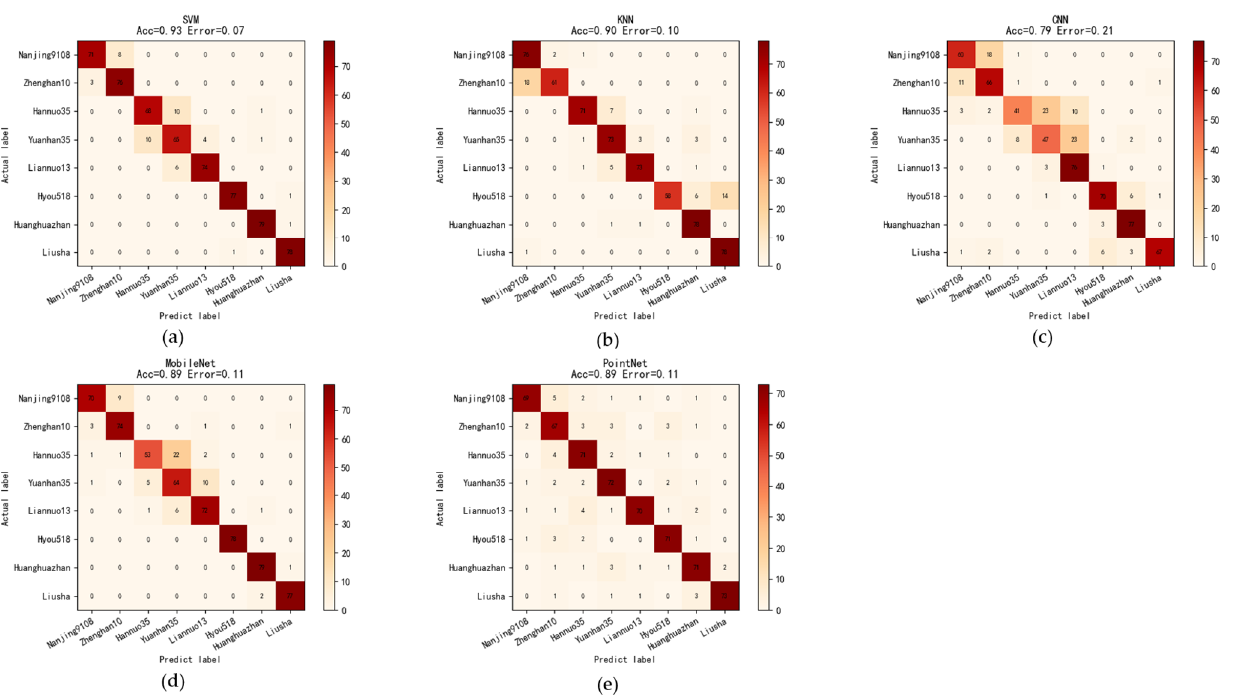
Figure 12. Confusion matrix. ( a ) SVM. ( b ) kNN. ( c ) CNN. ( d ) MobileNet. ( e ) PointNet. Table 2. Measures to evaluate the model performance.